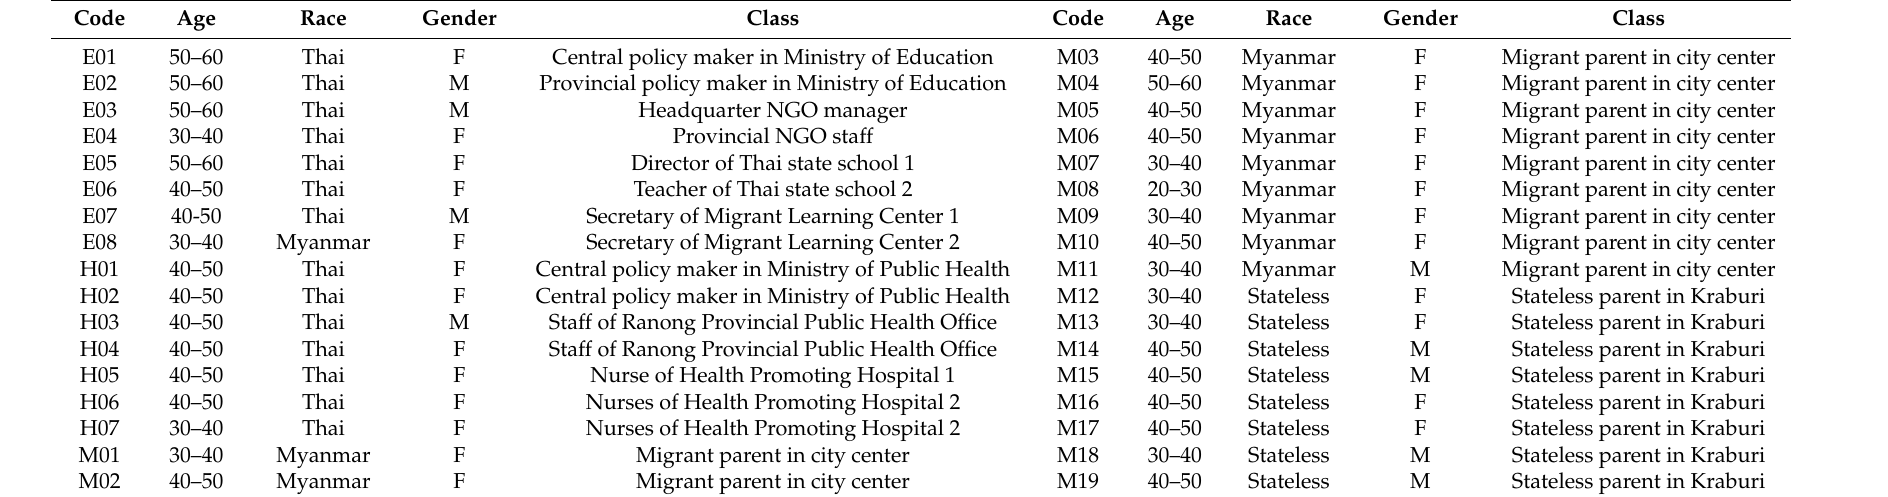
Abbreviations: F—Female; M—Male; NGO—Non-governmental